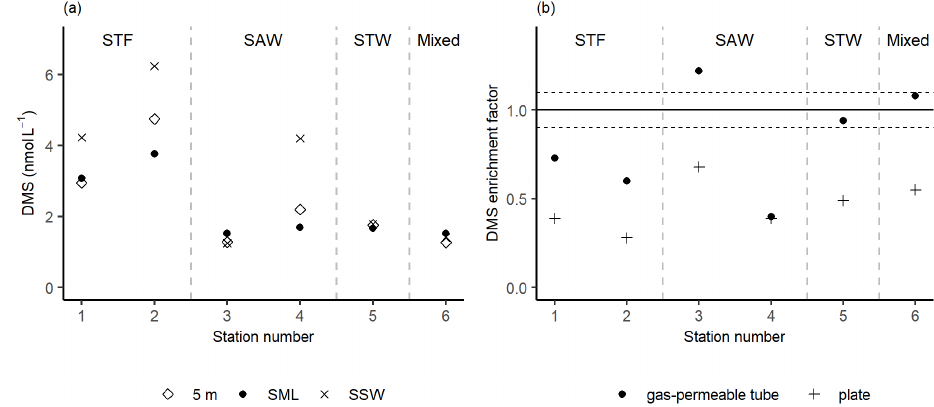
Figure 4. (a) DMS concentrations in the sea surface microlayer (SML) (using the gas-permeable tube), subsurface water (SSW), and at 5m depth. (b) DMS enrichment factor determined by the gas-permeable tube and glass plate. The horizontal dashed lines represent the significance threshold determined from the median repeatability of the gas-permeable tube (10%). Water mass type is indicated by the label at the top of the figure and separated by the grey vertical dashed